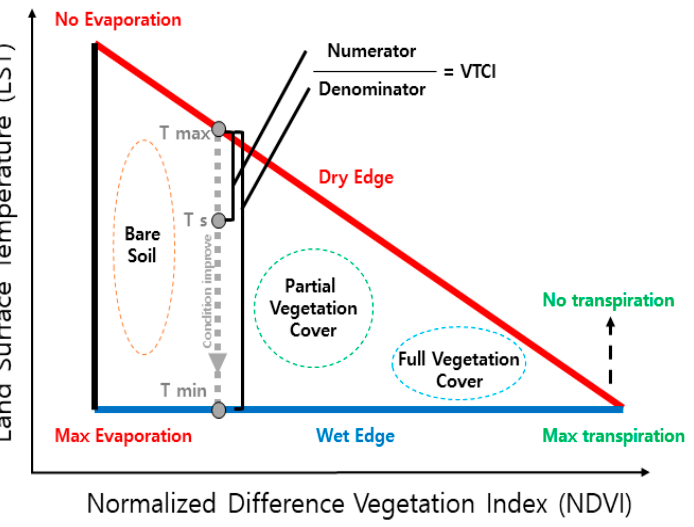
Figure 6. Concept of Vegetation Temperature Condition Index (VTCI) in the LST-NDVI feature space.